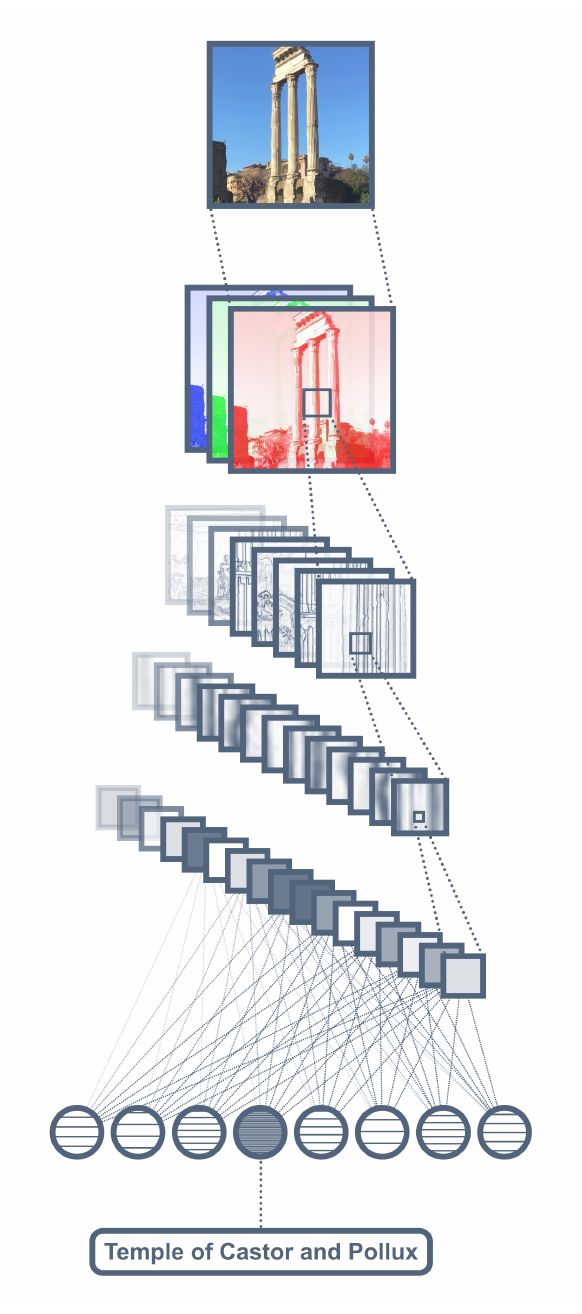
Figure 3. Illustration of a CNN on image